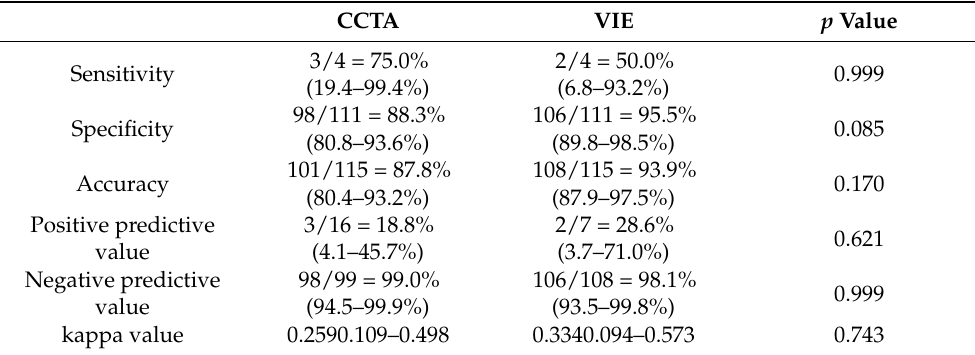
Table 3. Diagnostic performance of CCTA versus VIE in detecting coronary artery disease in 115 vessel segments with calcified plaques, using ICA as the gold standard.